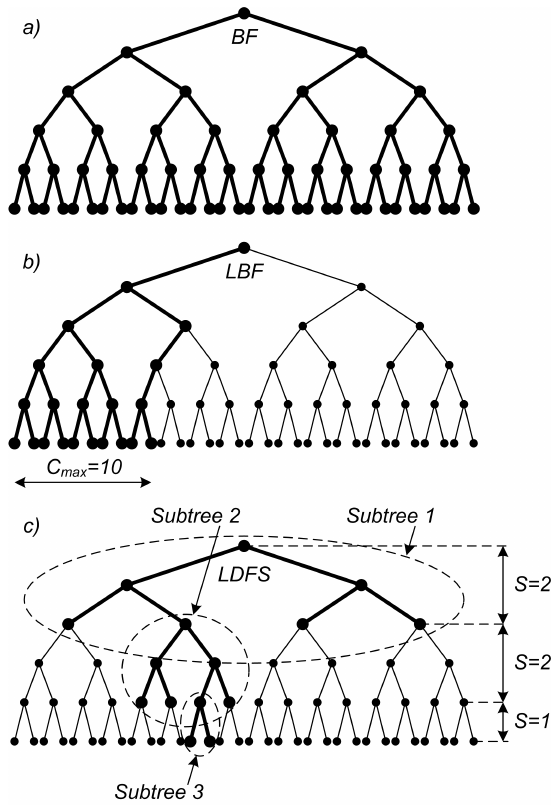
Figure 1: A schematic illustration of a combinatorial search tree traverse: a – within Brute Force method, b – within Brute Force method with restricted number of analyzed branches, c – within Brute Force with restricted depth of analyzed subtrees. Analyzed branches are